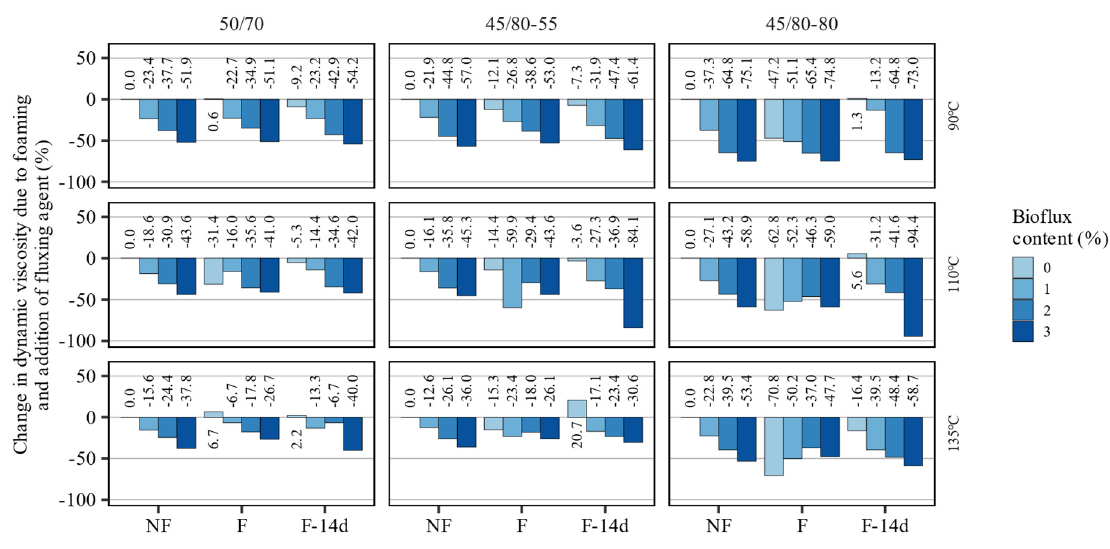
Figure 5. Results of dynamic viscosity measurements of the investigated asphalt binders.